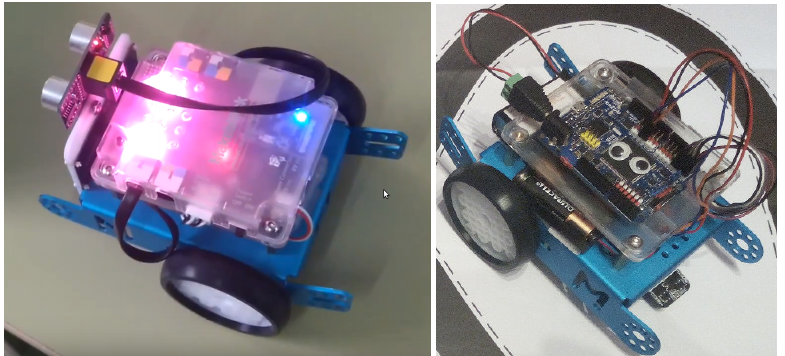
Figure 1. mBot robot: with original Arduino board ( left ) vs. with IceZum Alhambra FPGA board ( right ).